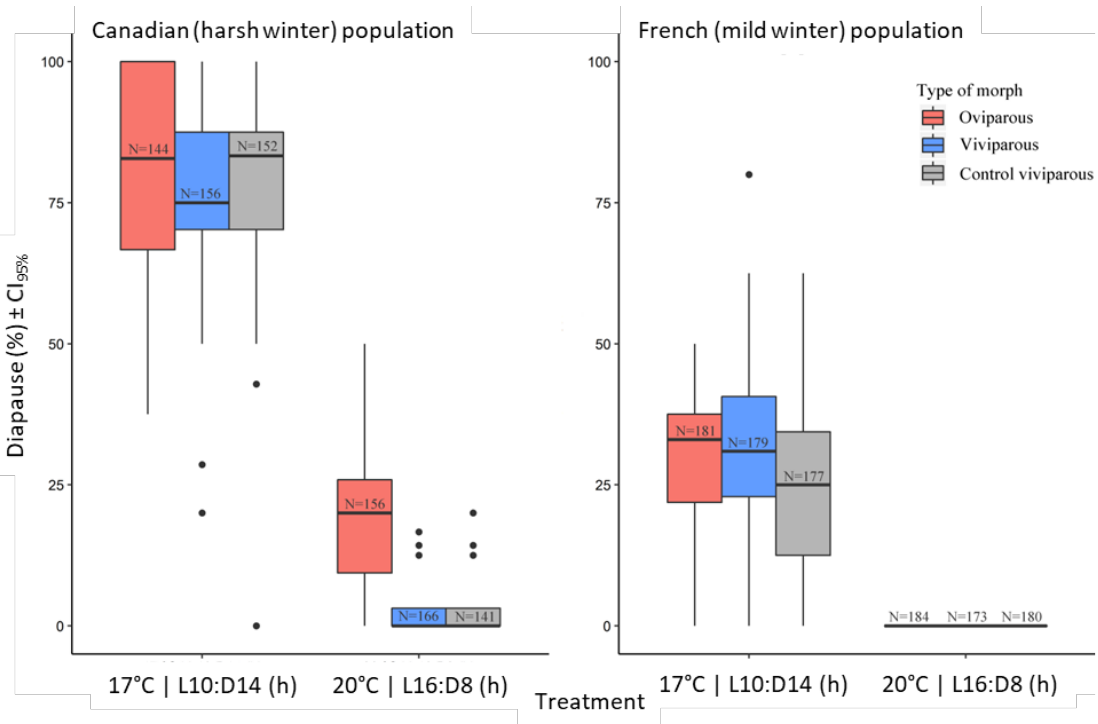
Figure 2 : Percent diapause incidence (± CI 95% ) in two Aphidius ervi populations. Left: Canadian population naturally experiencing harsh winter. Right : French population naturally experiencing mild winter. For both populations, three different morphs of the pea aphid Acyrthosiphon pisum (oviparous sexual females, viviparous parthenogenetic females produced under sexual-inductive conditions, and control viviparous females produced under non- sexual-inductive conditions) were used for parasitoid development, under two abiotic conditions (17 °C, 10:14 h L:D or 20°C, 16:8 h L:D). For each treatment, N represents the total number of parasitoid mummies used to calculate diapause